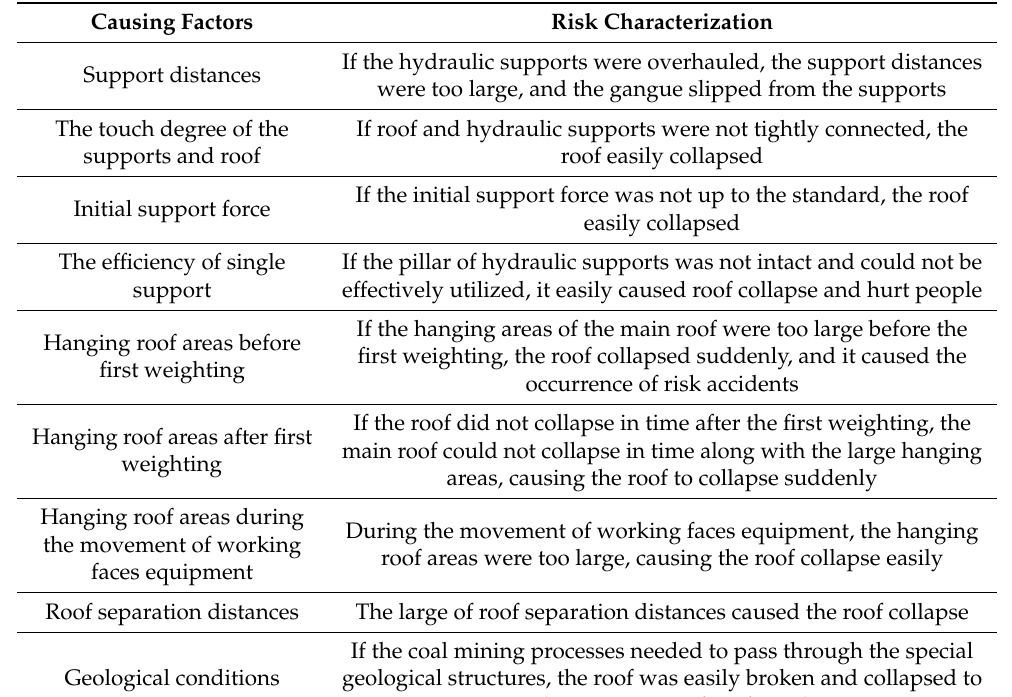
Table 2. Description of each factor and the characteristics of the risk of roof